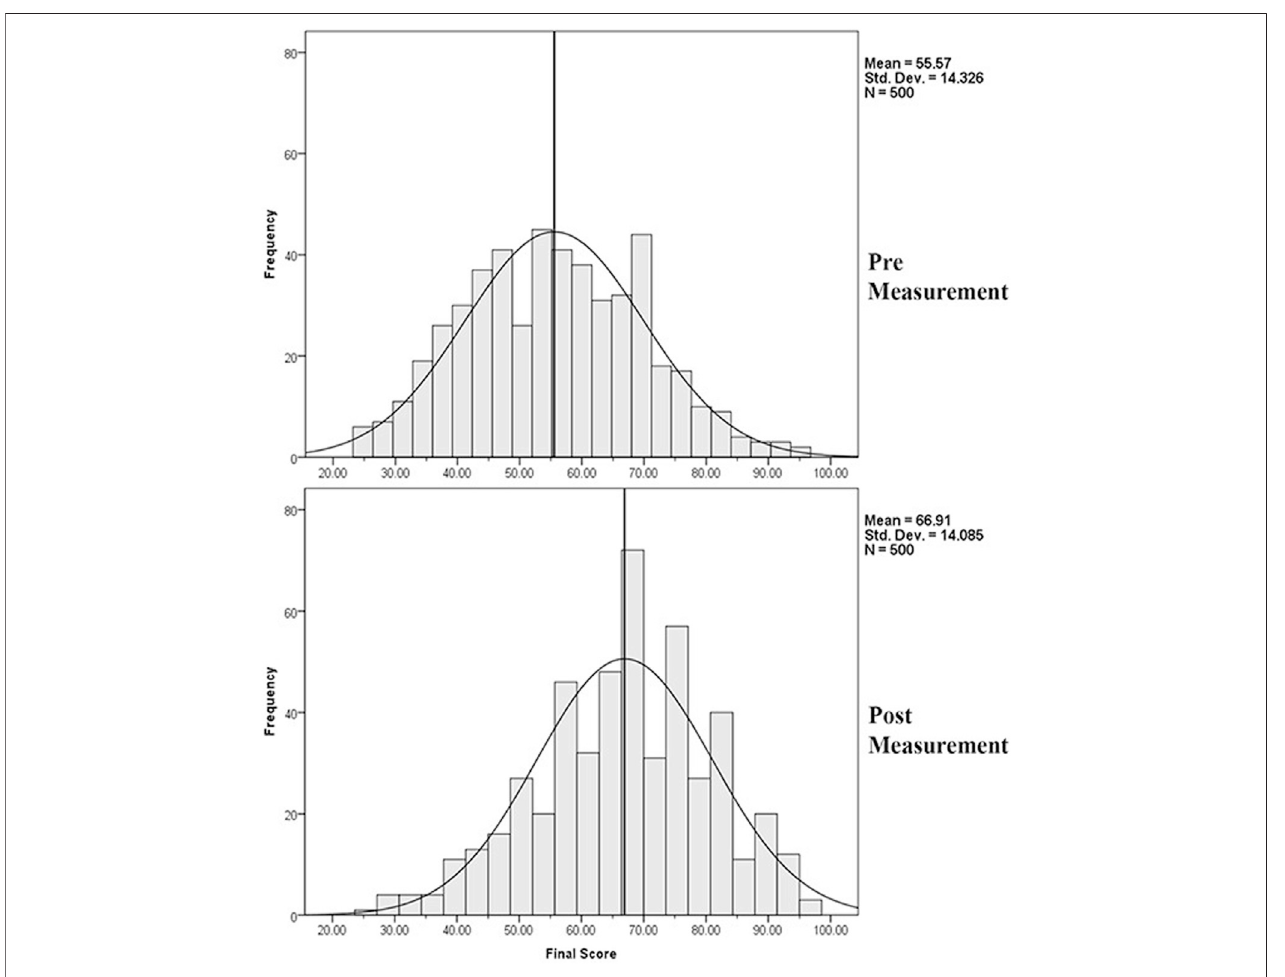
FIGURE 2 | Frequencies of the measurements (pre and post) of the school sample. In the upper graph, we can see the results from the pre-measurement, before the schools start implementing the proposed open schooling approach while in the lower graph, we can see the results of the post-measurement, after one-year intervention.TheFinalScoreindicatestheaverageresults (achievement) fromthethreelevelsofopenness.Theverticallineineach oneofthegraphsillustratesthemean value of the schools ’ scores in each one of the periods.